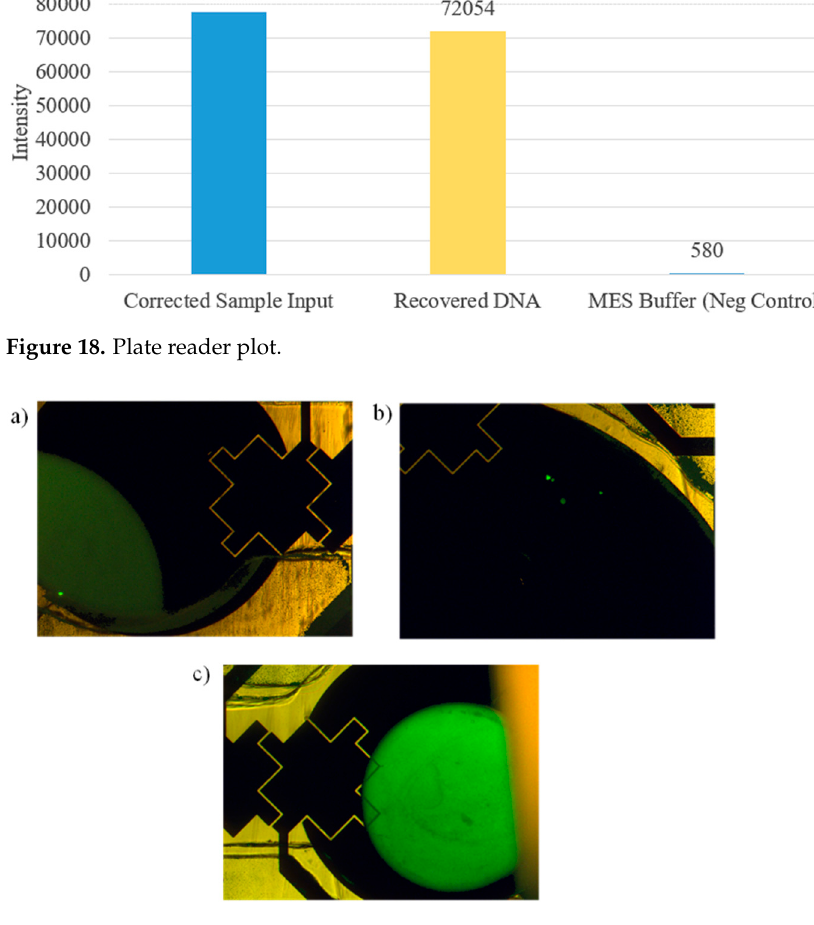
Figure 19. UV microscope images. ( a ) sample DNA; ( b ) waste reservoir; ( c ) recovered DNA in output reservoir.